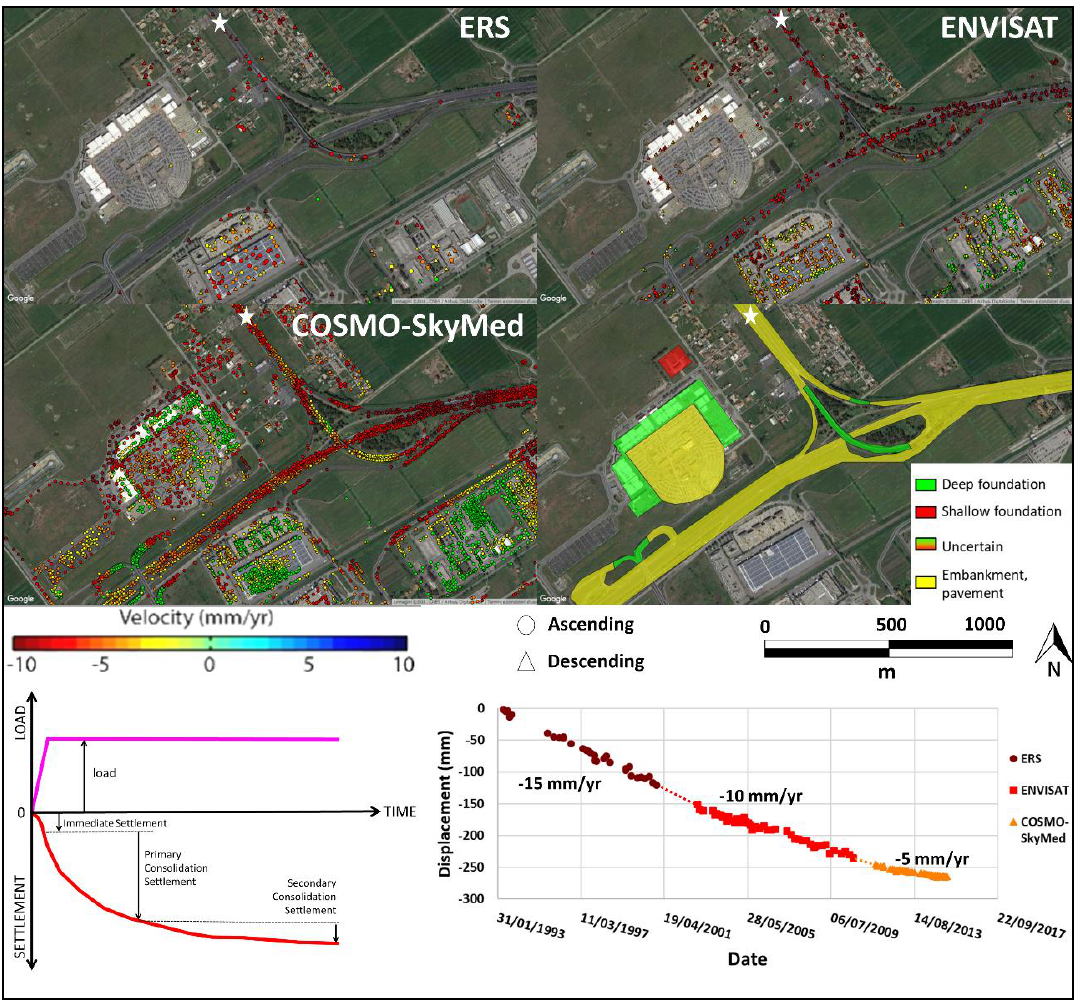
Figure 13 . View of the Da Vinci shopping centre and the Roma-Fiumicino highway. The foundation types of the most relevant structures and infrastructures and the displacement velocity measured on PSs with different SAR datasets are reported. The white star represents the location of the 22-year cumulative time series reported at the bottom right in which the decrease in settlement rates over time is evident and in accordance with the typical consolidation curve (bottom left).